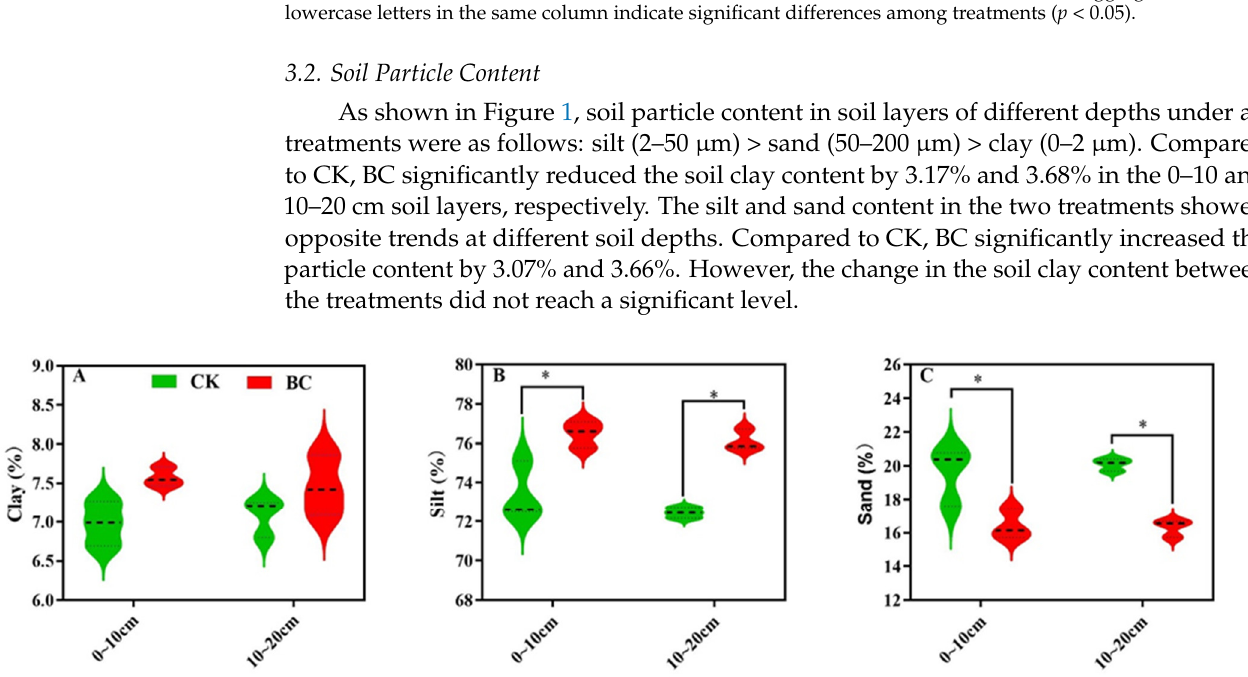
Figure 1. Effect of biochar on the percentage of clay ( A ), silt ( B ) and sand ( C ) in dry direct-seeded rice field. CK, conventional fertilizer; BC, biochar with conventional fertilizer. * Indicates significant difference between CK and BC treatments ( p <